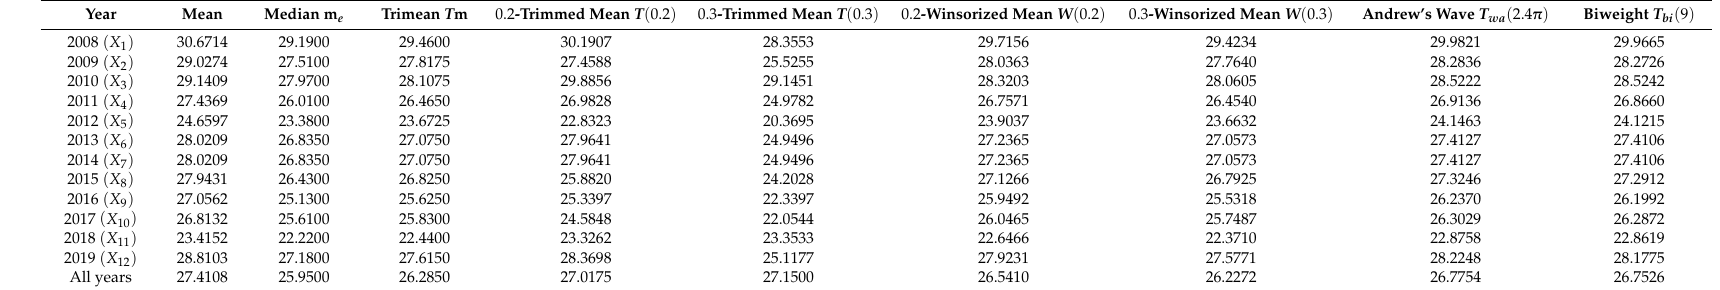
(cid:16) (cid:17) µ g/m 3 .